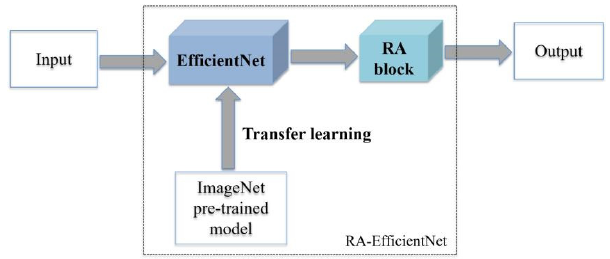
Figure 4. The structure of feature extraction network.